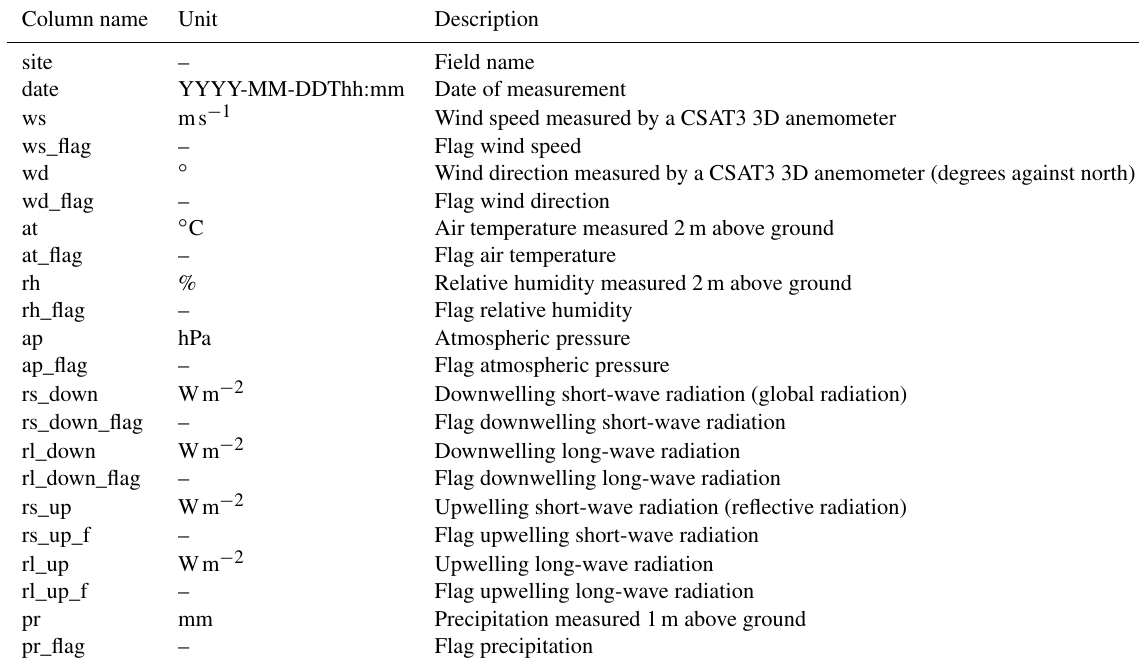
Table 11. Determined variables and description of the weather data files